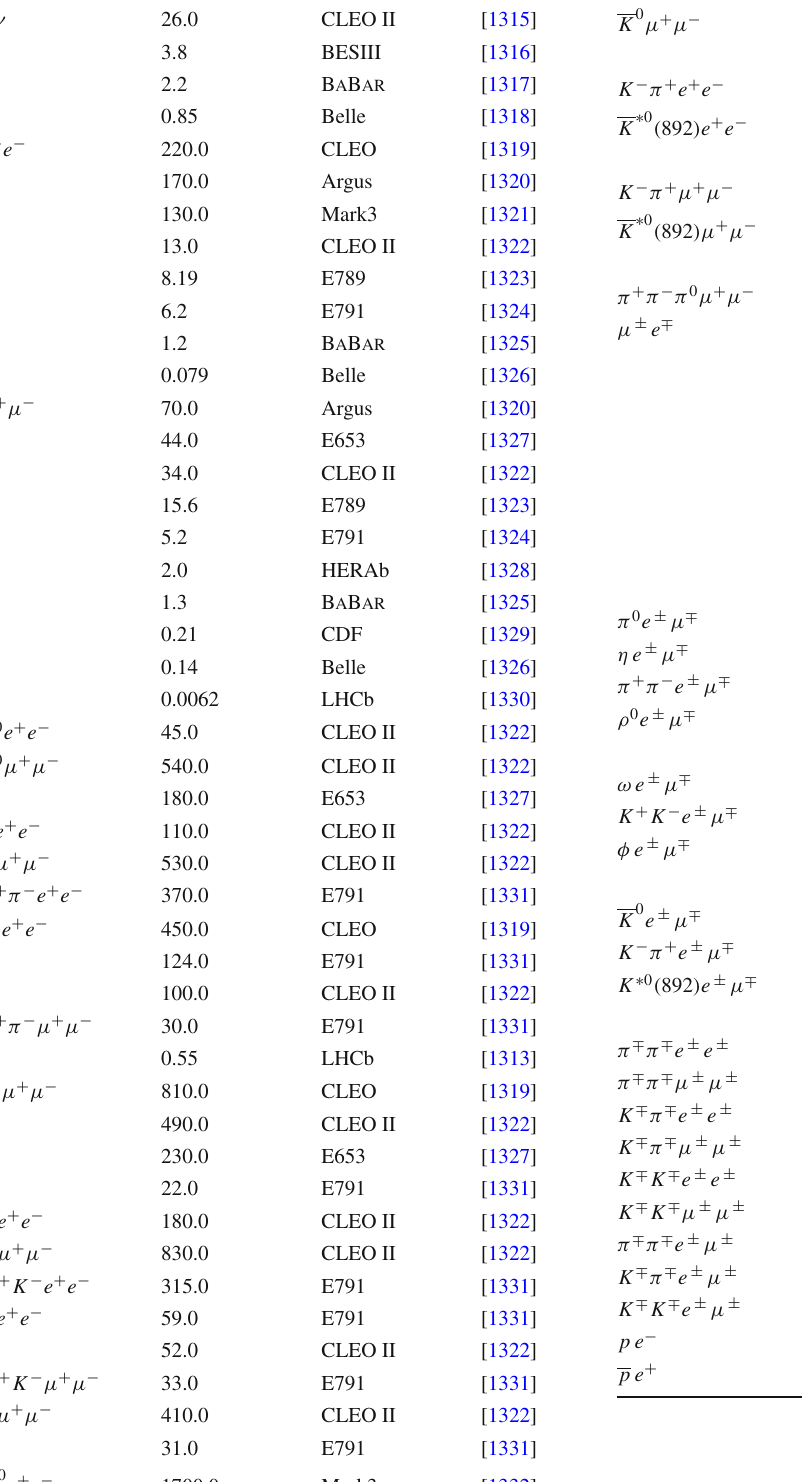
Table 300 Upper limits at 90% C.L. for D 0 decays